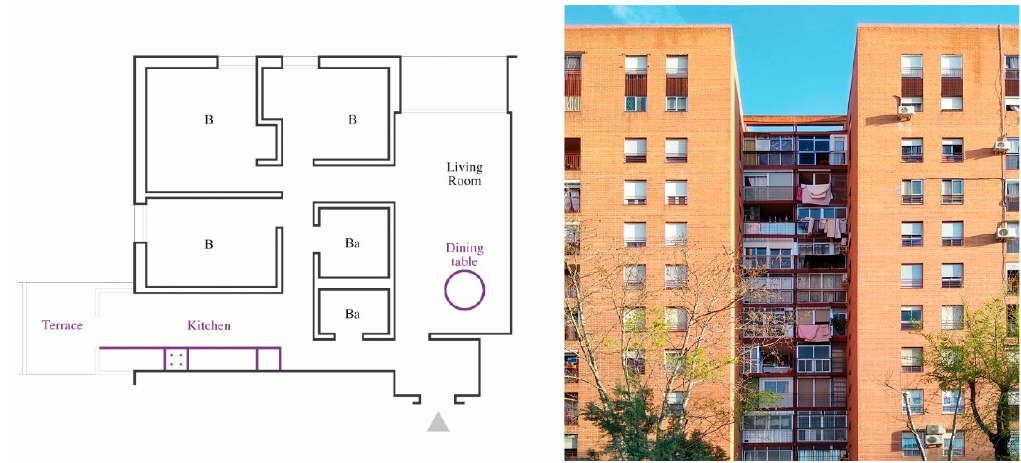
Figure 8. VICOMSA residential blocks in Palomeras Sureste, UD 5 mega-block. Three-bedroom apartment. Plan redrawn and photo by author.